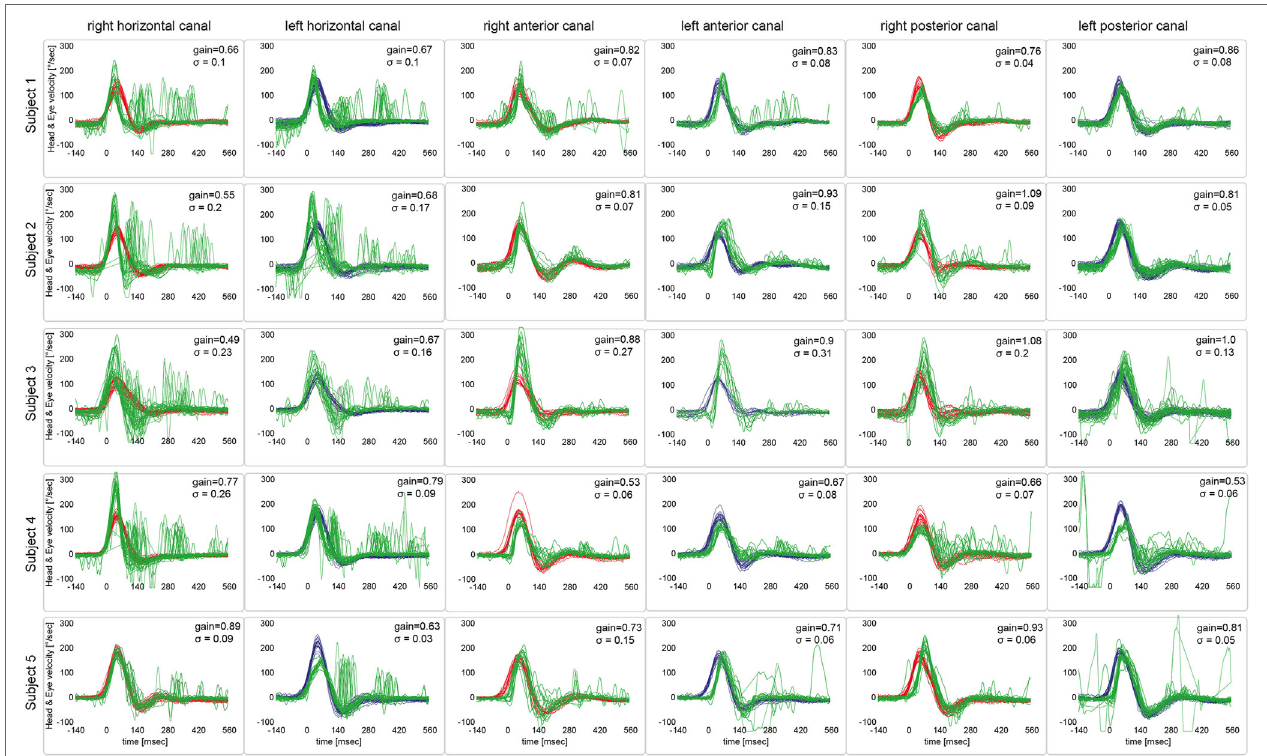
FigUre 3 | Video head-impulse testing from all five patients, showing the results from a single subject in one row. For each semicircular canal, individual eye velocity traces (in green) and head velocity traces (in red for assessing the right vestibular organ and in blue for assessing the left vestibular organ) are plotted against time. Note that eye velocity traces are inverted to allow for better visualization and comparison with the head velocity traces. While upbeat nystagmus was present at the time of vHIT recordings in patients #1 and #5, this did not result in an increased number of saccades on the traces or reduced